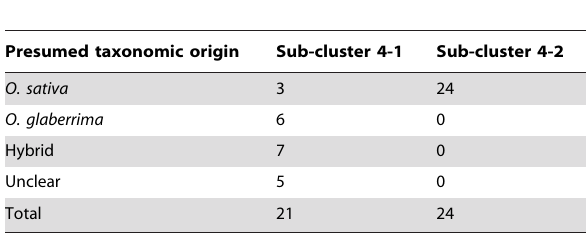
Table 2. Presumed taxonomic origin of the farmer hybrid varieties observed in sub-clusters 4-1 and 4-2 in Fig.